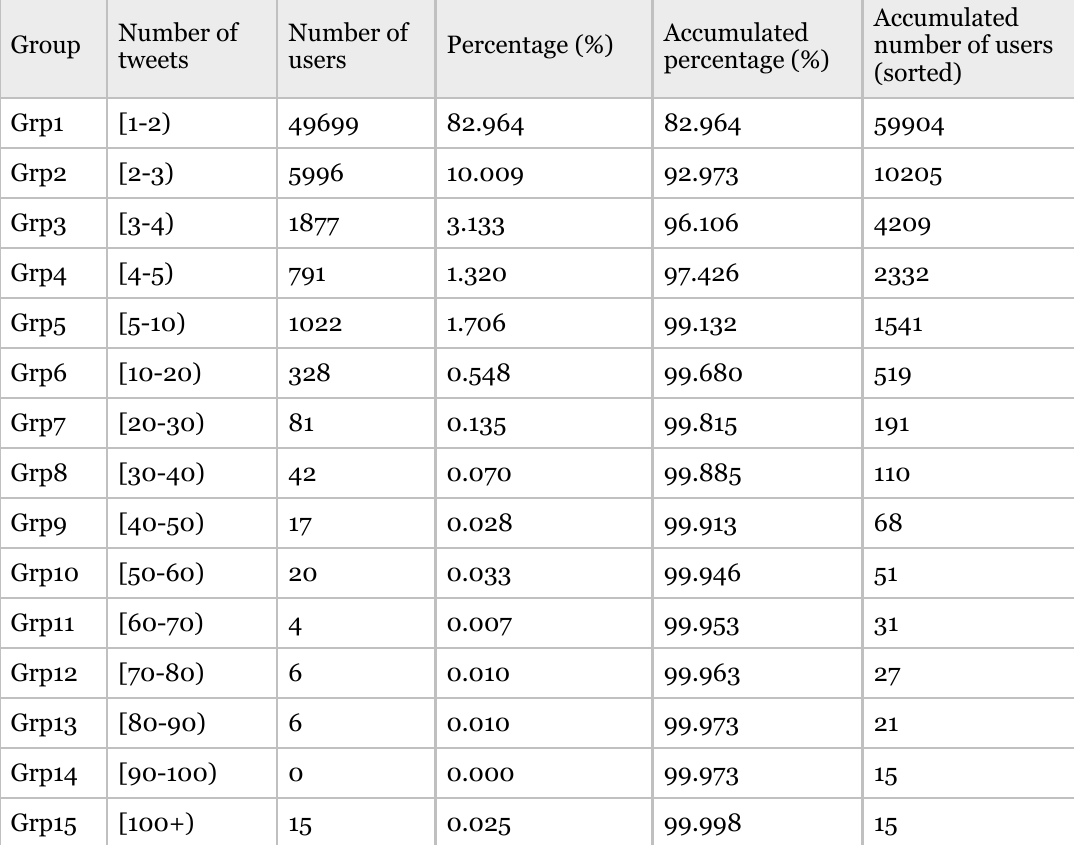
Table 2: The category of users measured by the number of tweets published.